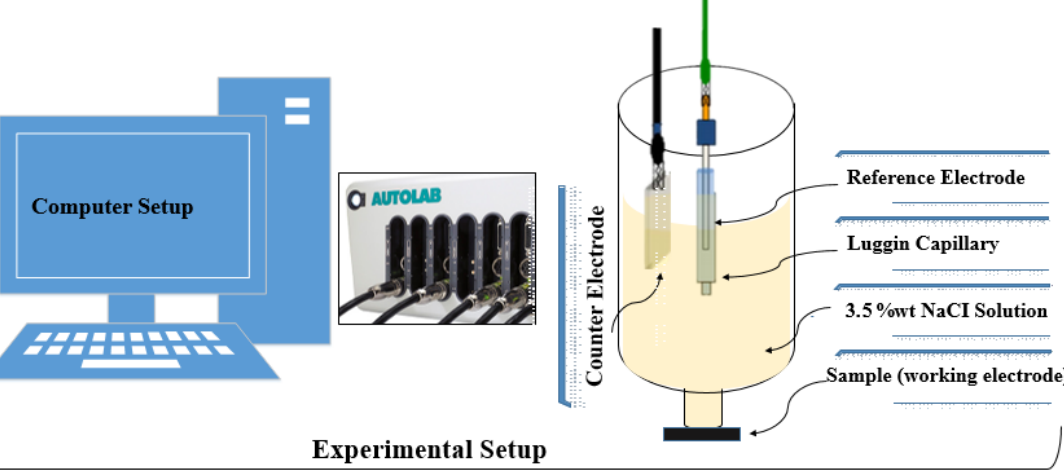
Figure 1. Experimental setup for potentiodynamic